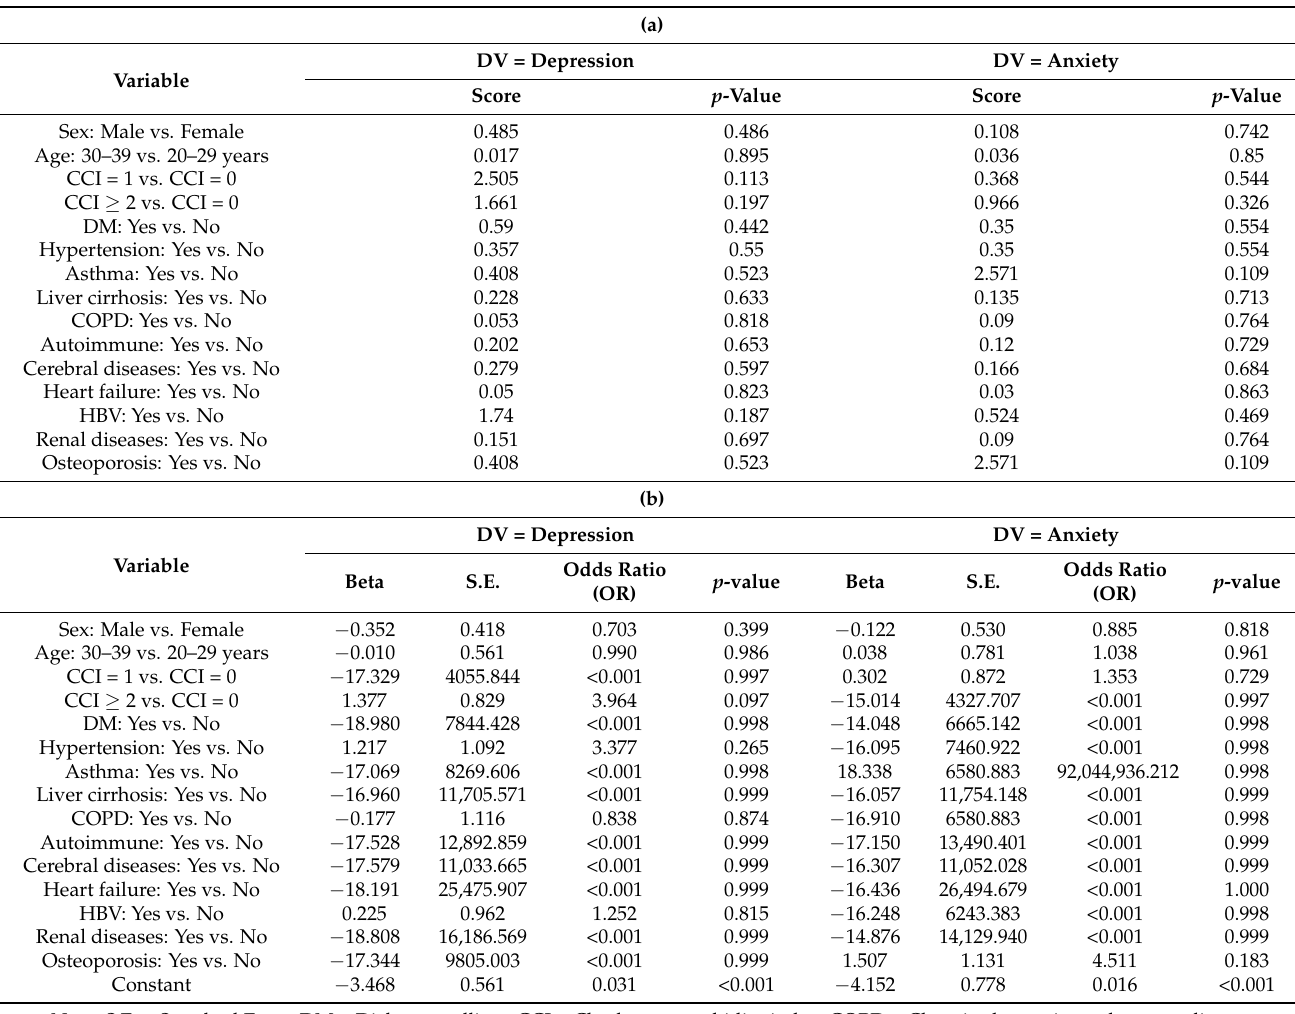
Table 3. ( a ) Score test results for each variable of the logistic regression model. ( b ) Results of multiple logistic regression models for depression and